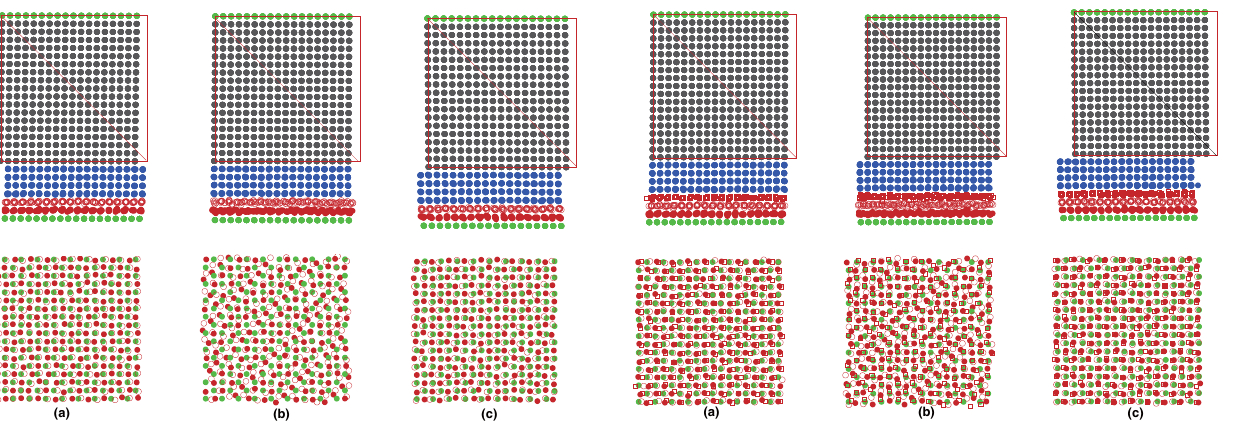
Fig. 12 Atomistic structures ( x – z side view and x – y bottom view) of the two-layer molecular tribological system at (a) 0 2   , (b)  = 0.0, and (c)  = 0.2. The fluid atoms in the second layer are represented by the open red spheres. The wall, the elastic substrate, and the fluid atoms in the first layer are represented by the green, blue, and filled red spheres, respectively. The coarse-grained far region of the substrate is represented by the gray spheres.